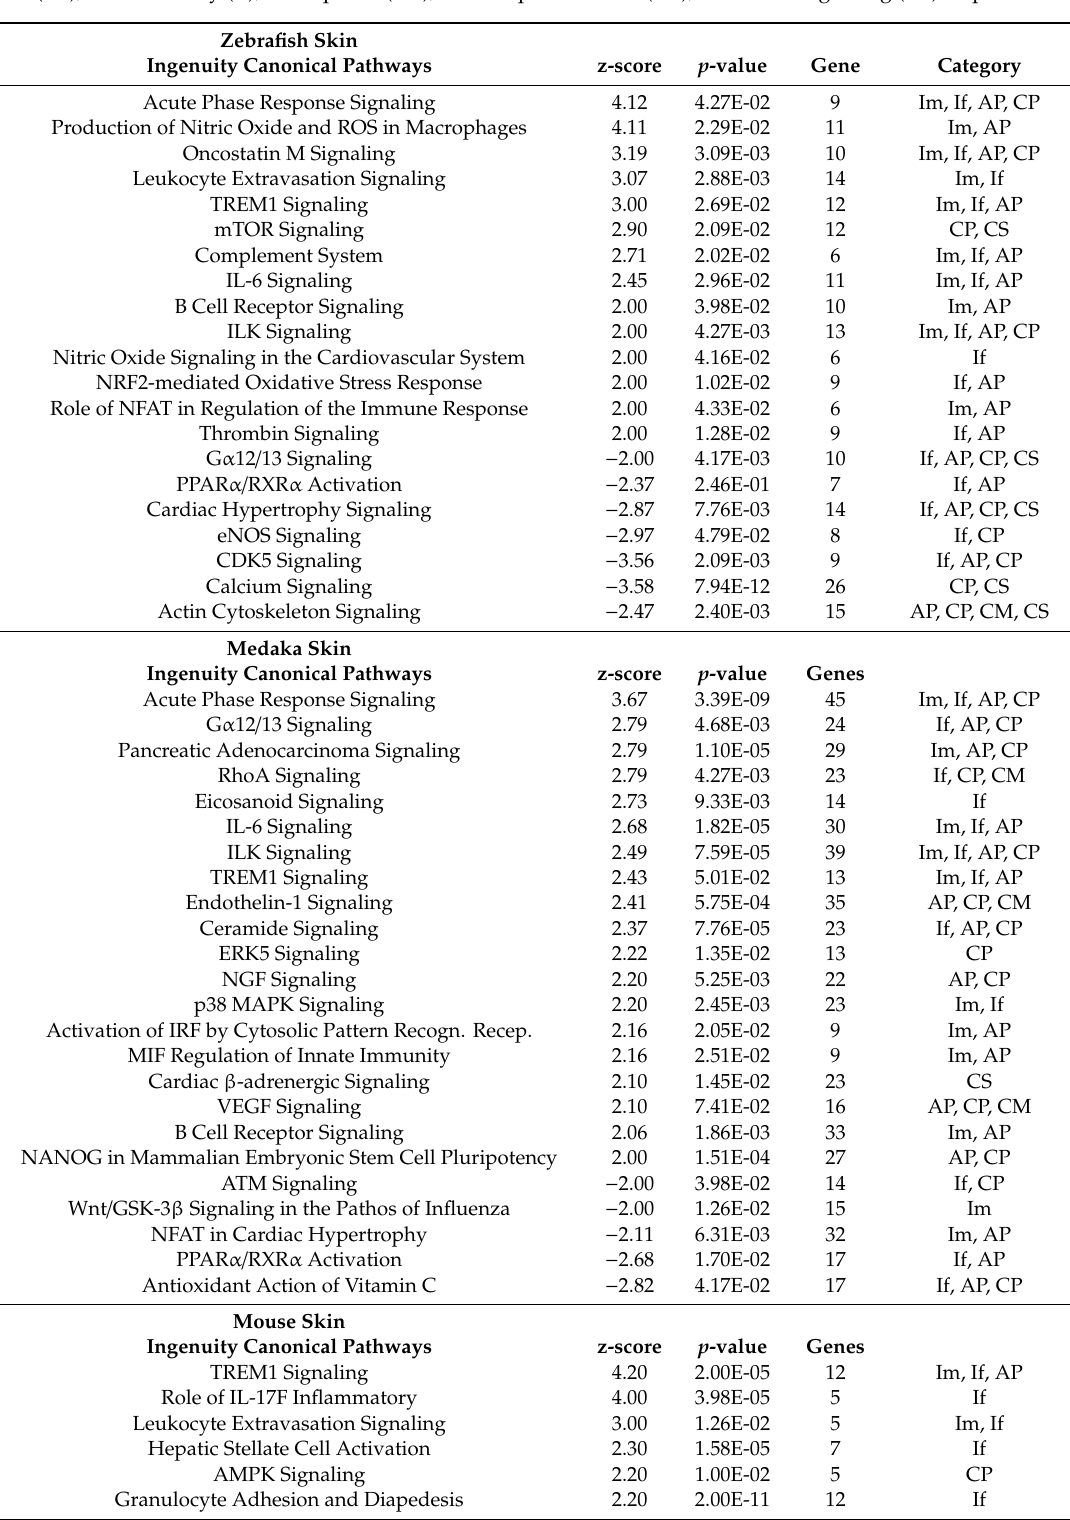
Table 2. Modulated canonical pathways were predicted using IPA for zebrafish (top), medaka (middle), and mouse (bottom) skin. All pathways with a z-score ≥ | 2 | , p -value < 0.05, and five or more genes were included in the analysis. The column on the far right indicates if the pathway is involved in an immune (Im), inflammatory (If), acute phase (AP), cellular proliferation (CP), or cellular signaling (CS)